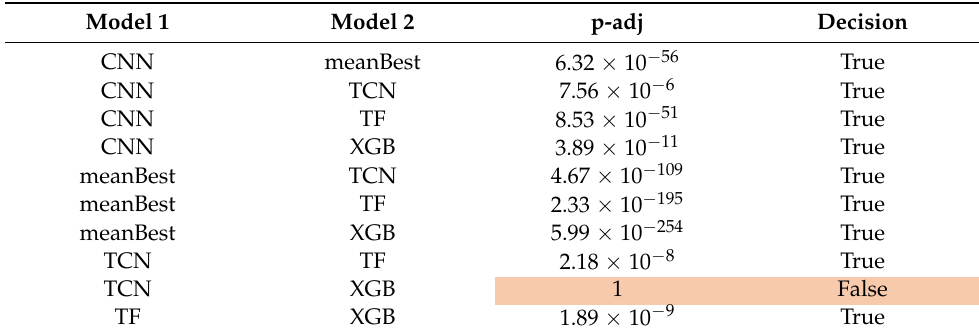
Table 5. ANOVA test results for building